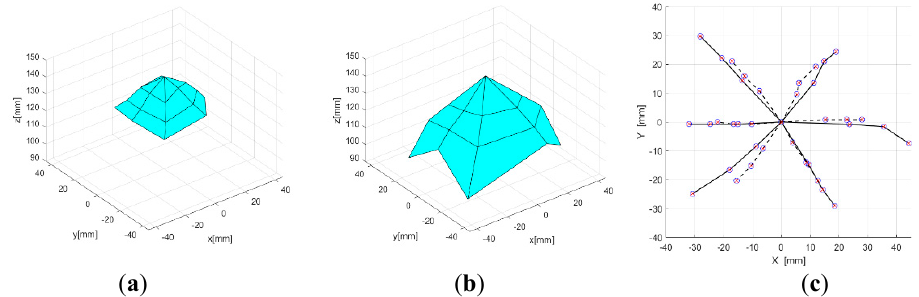
Figure 14. 3D work space of prototype C: ( a ) complete; ( b ) without antagonistic wires; ( c ) X-Y projection of the workspaces, (cross: experimental, circle: mean values; solid line: with antagonistic wires, dotted line: without antagonistic wires).